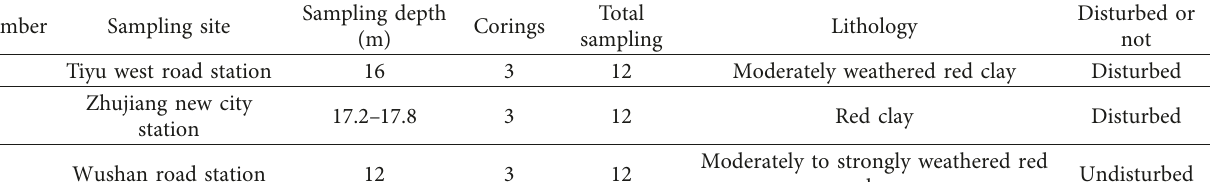
Table 1: Microexperimental soil samples of typical red-layers.